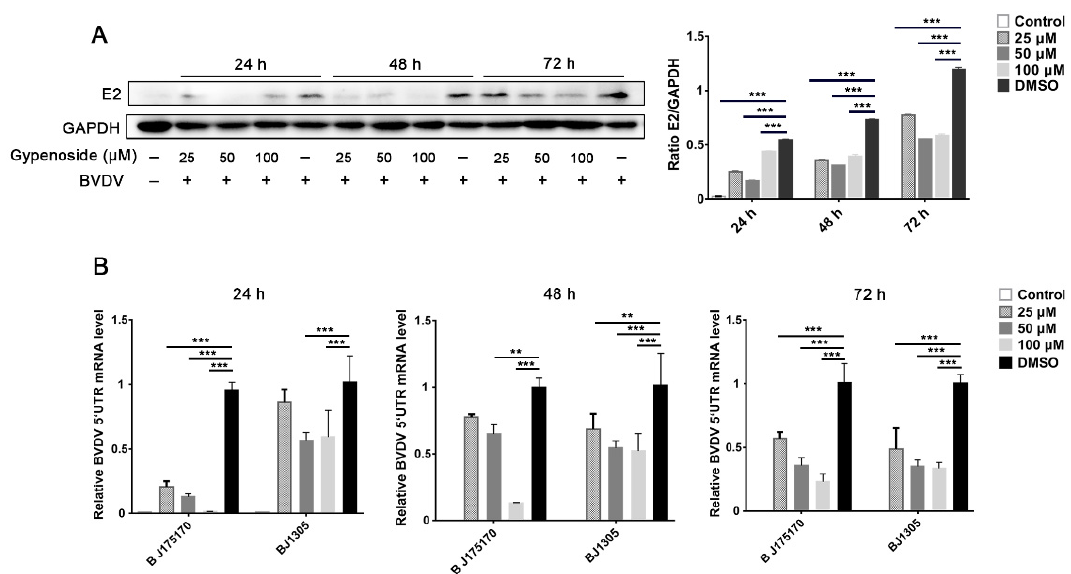
Figure 2. Continuous gypenoside treatment inhibits BVDV infection in the MDBK cells at 72 hpi. ( A ) The effects of the indicated concentrations of gypenoside (25, 50, and 100 µ M) on BVDV infection in MDBK cells for the different times (24–72 h) detected with Western blotting. The BVDV E2 protein band was quantified as the ratio of the intensity of the BVDV E2 protein band to that of the GAPDH band in Western blotting. ( B ) The effects of the indicated concentrations of gypenoside (25, 50, and 100 µ M) on the expression of BVDV 5’UTR mRNA in MDBK cells for the different times (24–72 h) detected with RT-qPCR. Data from three independent experiments and error bars are presented as the mean ± SEM. ** p < 0.01, *** p < 0.001.